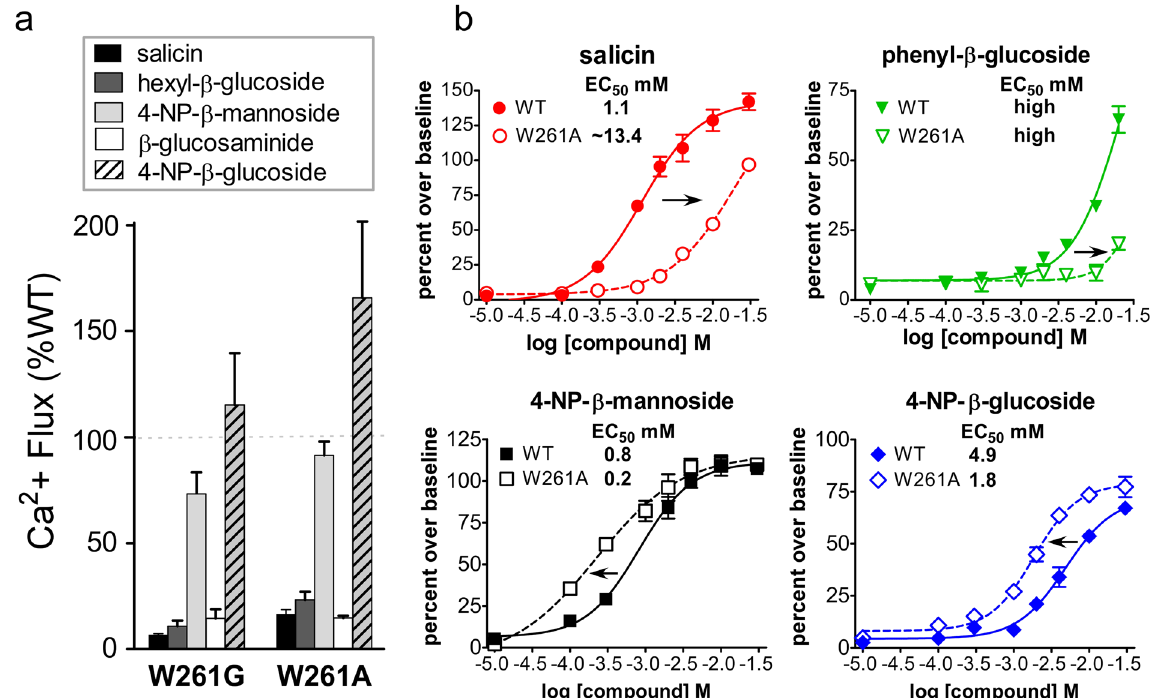
Figure 5. A mutation at TAS2R16 position 261 results in loss or gain of activity. ( a ) Activation of W261G and W261A TAS2R16 variants with a variety of ligands, activities shown as a % of their activation with wild-type TAS2R16. ( b ) Dose-response studies performed for wild-type (WT; solid symbols) and W261A TAS2R16 (open symbols) using the indicated